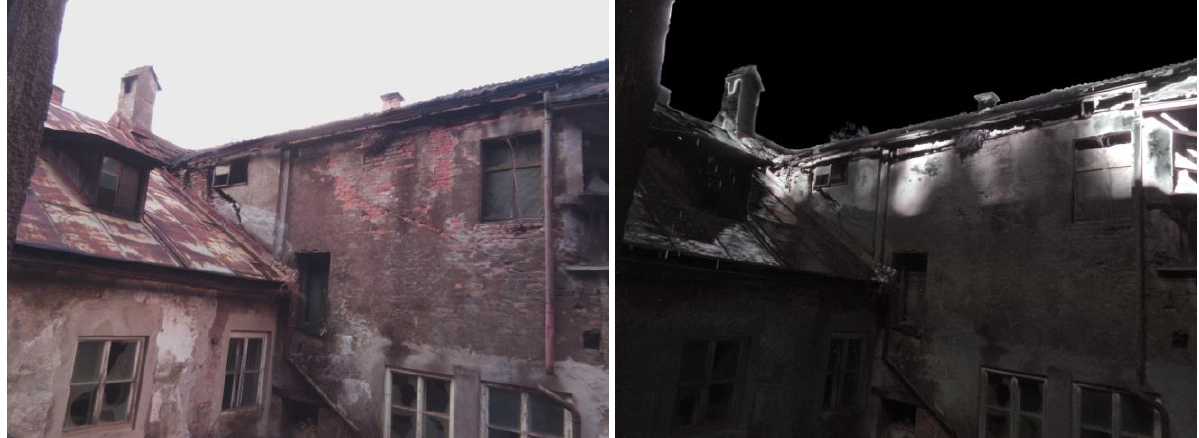
Figure 6 | Single photo and differential integration of 269 frames.